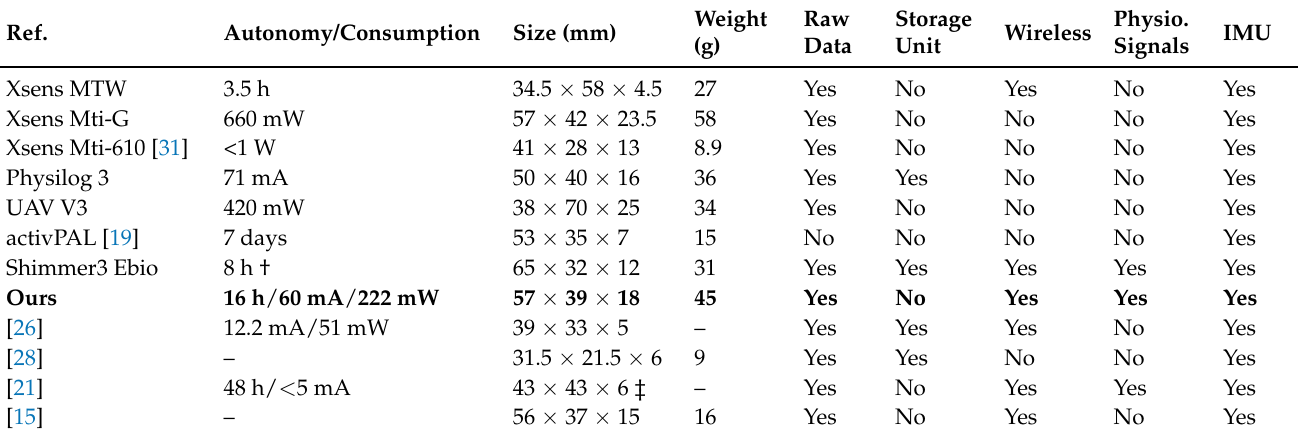
Table 8. Main features for some commercial wearable units and devices found in the scientific literature. † Consumption when streaming; ‡ Equivalent area for a circular-shape wearable.